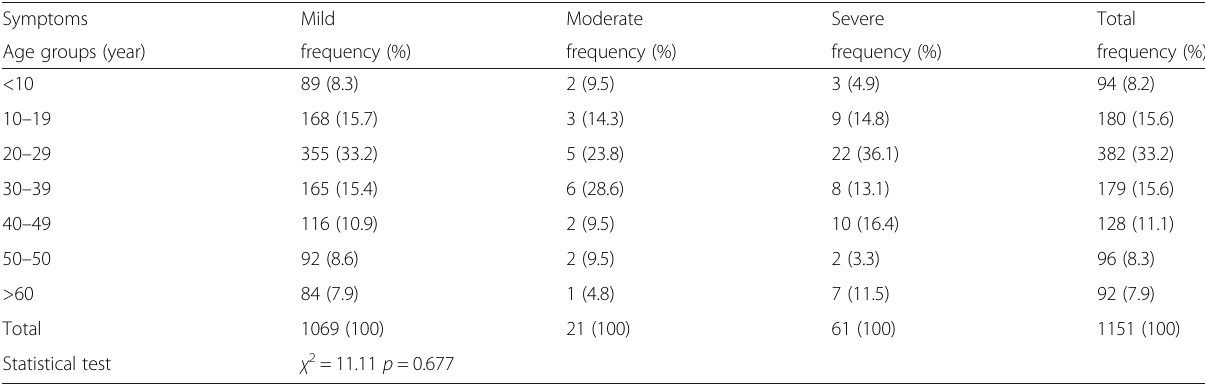
Table 3 Difference among age groups as to symptoms Symptoms Mild Moderate Severe Total Age groups